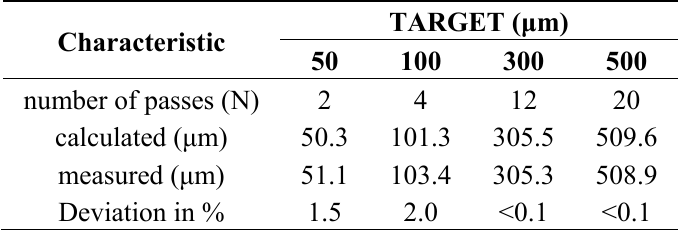
Table 2. Comparison of targeted, calculated and measured ablation depth for